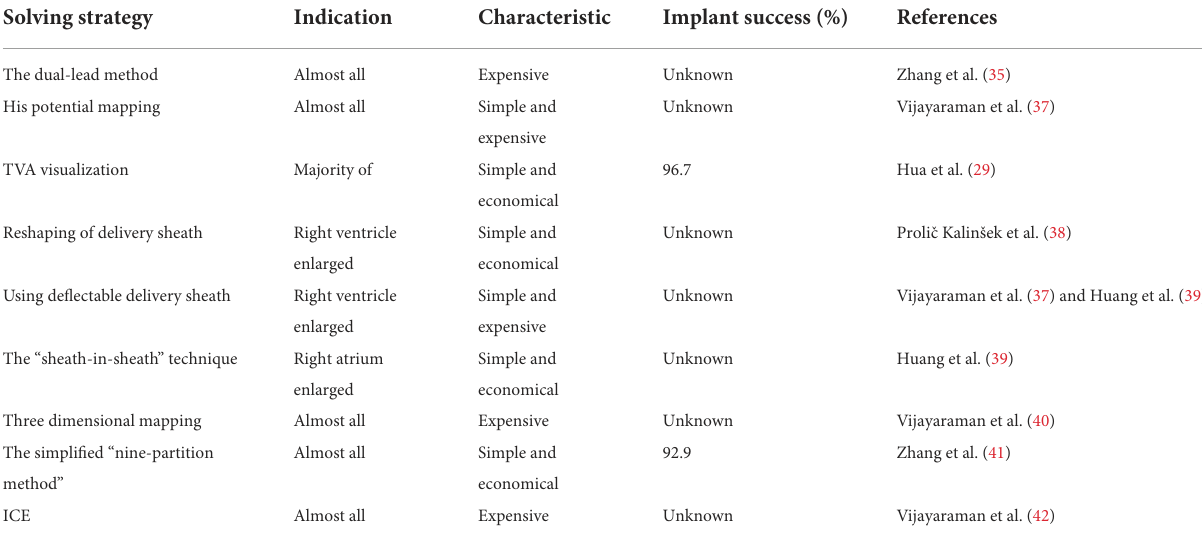
TABLE 2 The strategy of improving the success rate of